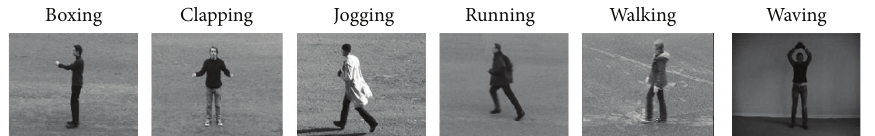
Figure 4: The figure depicts KTH human action dataset. To test the recognition of biological movements one of the well-known human action recognition datasets has been utilized in its performance. Here, the set represents KTH human action dataset. It is noticeable to mention that KTH dataset is one of the largest human action datasets having six various human actions in four different scenarios.